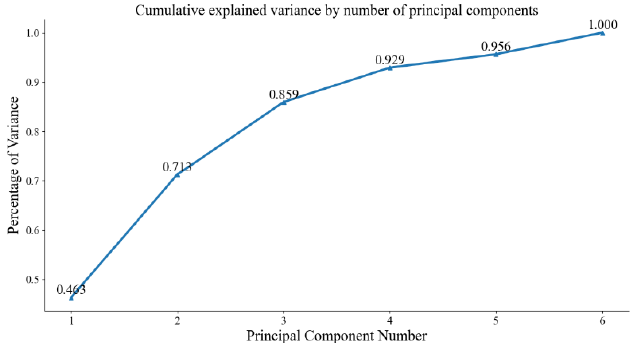
Figure 9. Cumulative explained variance by number of principal components.